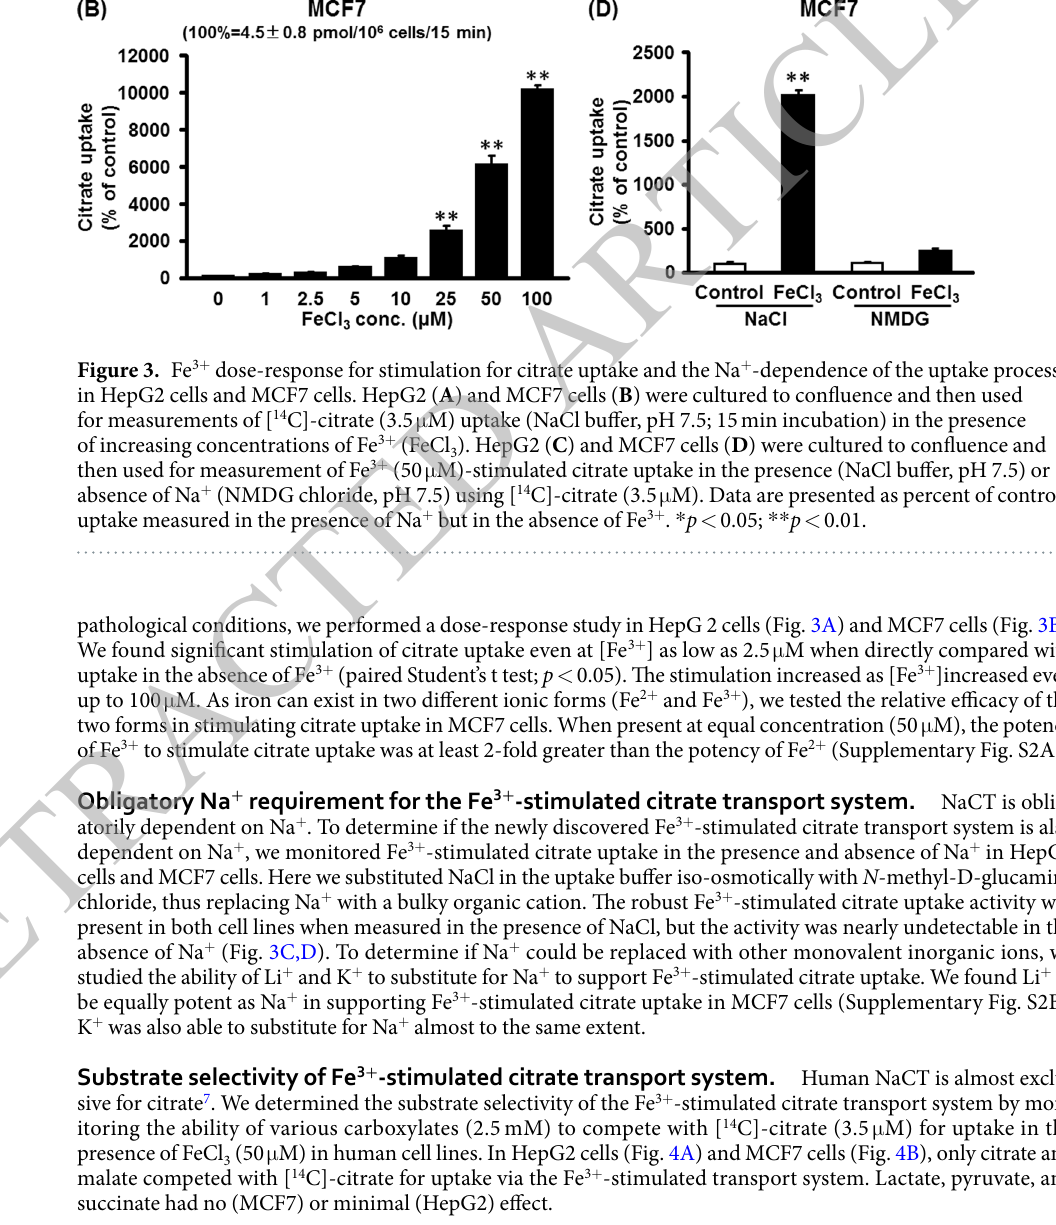
the presence of FeCl 3 . Unlabeled citrate competed with [ 14 C]-citrate for NaCT-mediated uptake at millimolar